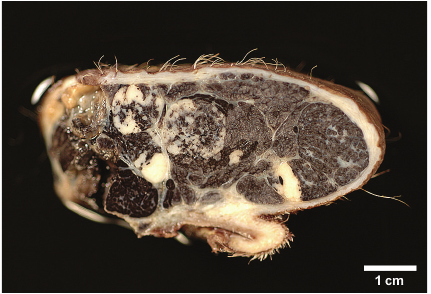
Figure 2: Cut surface of the solid basal cell tumor in a Namibian cheetah (5.5 cm in